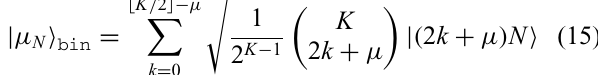
FIG. 3. Noise model considered for the telecorrection circuit in Fig. 2. We restrict our numerical analysis to the two classes of RSB codes discussed in Sec. II C. The encoded data qubit undergoes a simultaneous loss and dephasing channel N ( · ) prior to error correction. The noise channel is obtained by